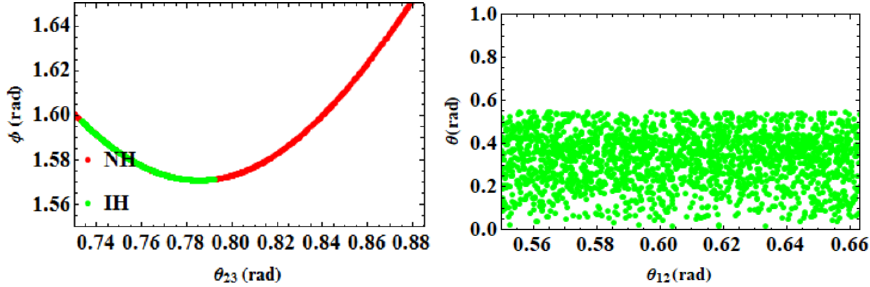
Figure 1 . Variation of the TM mixing angle (cid:30) and (cid:18) with the atmospheric and solar mixing angle, (cid:18) 23 and (cid:18) 12 .